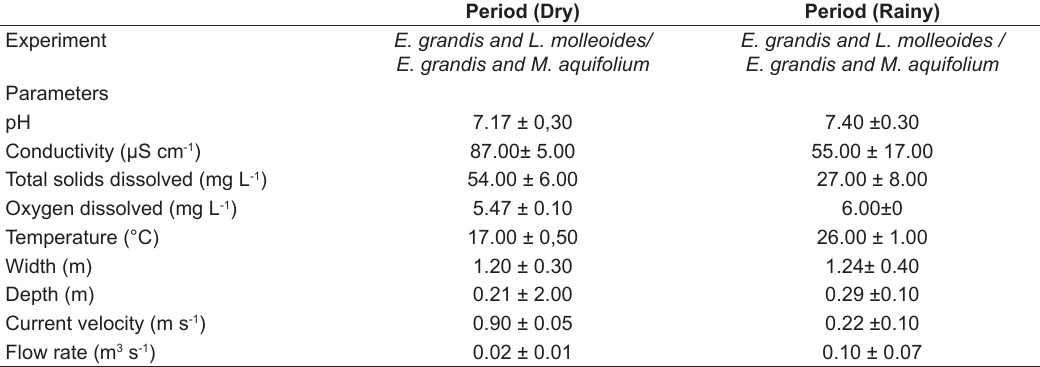
Table 1. Physical and chemical characteristics of the Campininha stream, during the study period. The data represent mean values and the standard